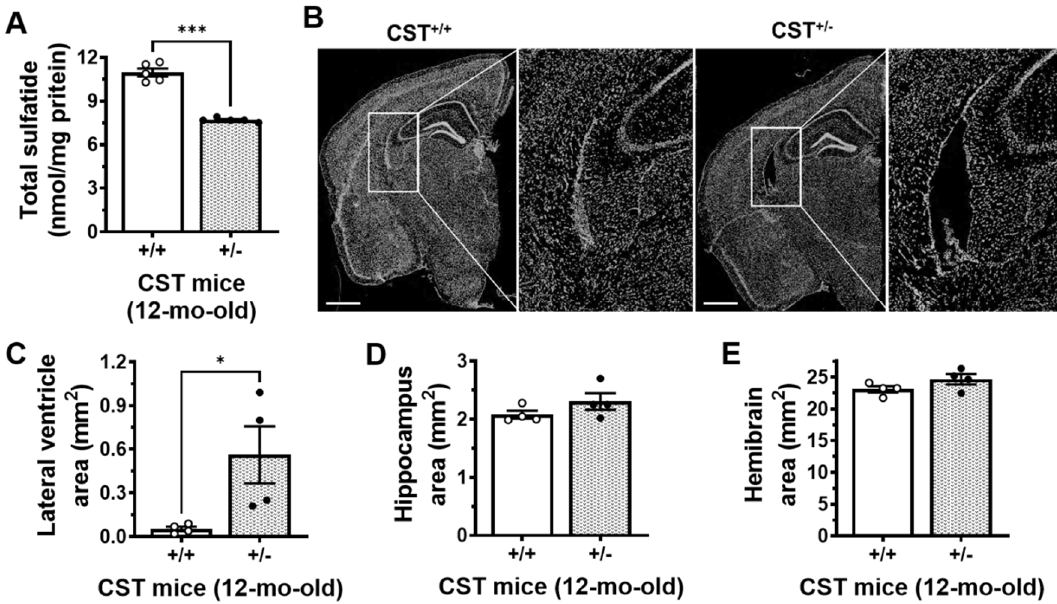
Figure 1. Mild sulfatide deficiency leads to middle ‐ age ventricular enlargement in the mammalian brain. ( A ) Total sulfatide levels in the cerebrum of CST +/+ and CST +/ − littermate mice measured by MDMS ‐ SL. ( B ) DAPI ‐ (nuclear) stained coronal sections from CST +/+ and CST +/ − mouse brains on a C57BL/6J background at 12 months of age. Scale bar: 1 mm. Lateral ventricle ( C ), hippocampal ( D ) and whole hemibrain ( E ) areas from CST +/+ and CST +/ − mice. Anatomical areas were quantified using Image J. N = 4–5 mice/genotype. Each dot represents average data from 2–4 sections (Bregma − 1.8 to − 2) for each animal. Unpaired two ‐ tailed t ‐ test (normality and equal variance were assumed/confirmed). * p < 0.05, *** p < 0.001.